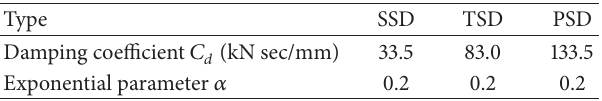
Table 2: Damping coefficient and exponential parameter of the